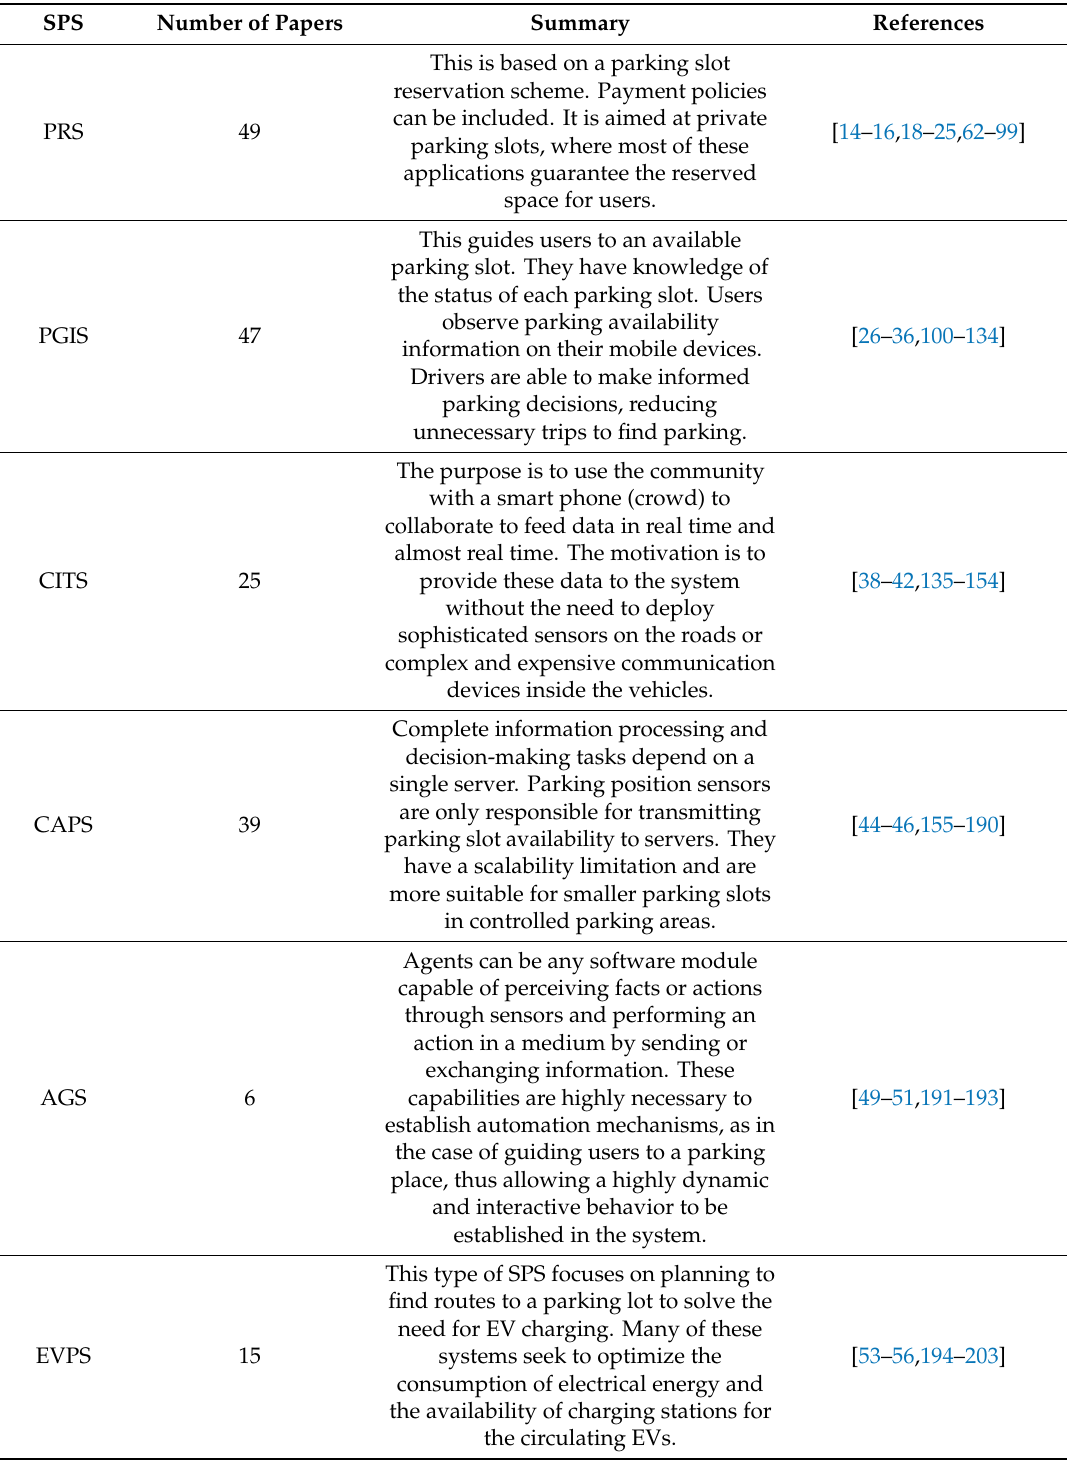
Table 5. Number of publications for each SPS type, along with a summary and references.